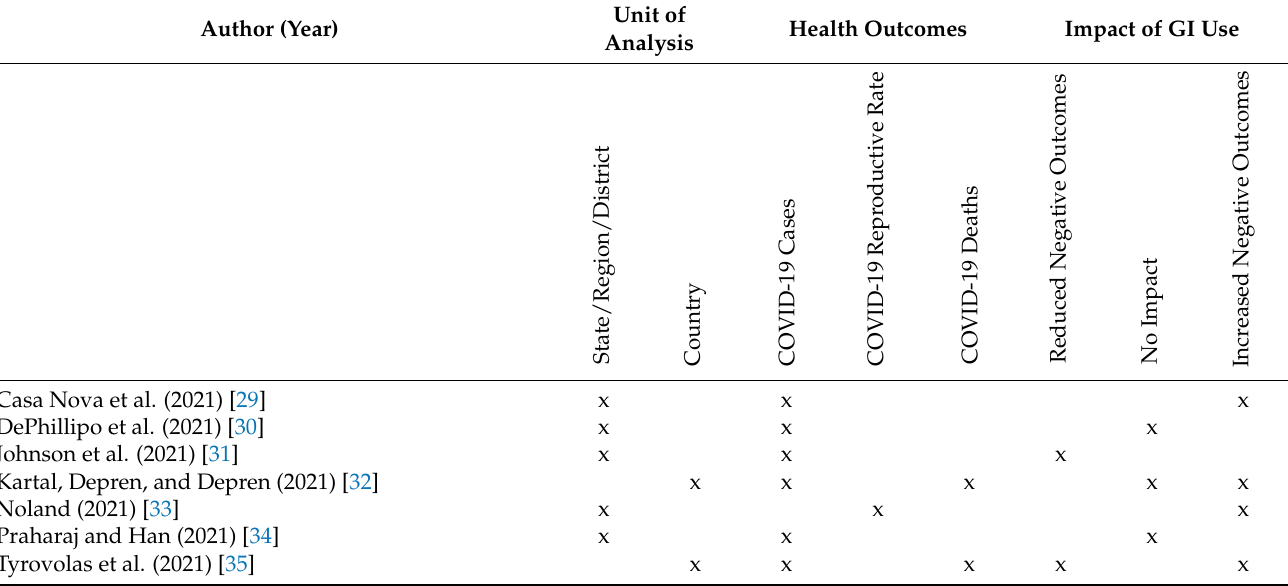
Table 1. Summary chart of articles identified in theme 1: the impacts of GI use on COVID-19-specific health outcomes. Author (Year)